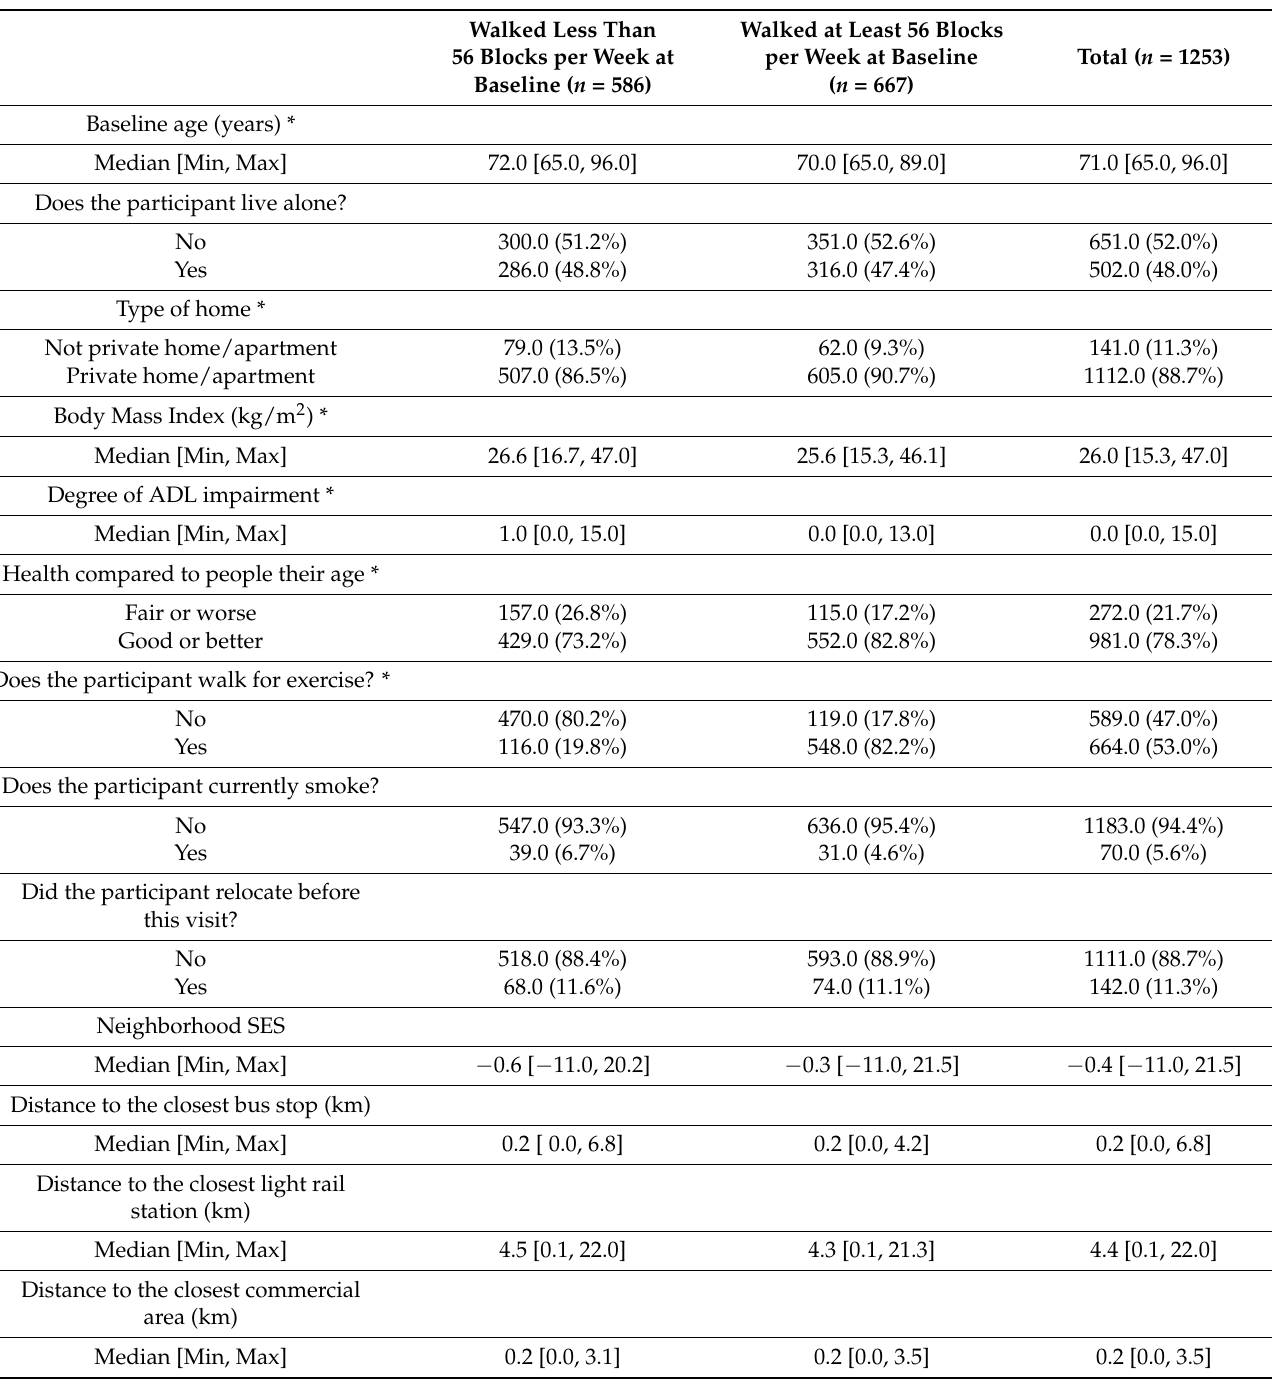
Table 1. Baseline characteristics of the sample stratified by number of blocks walked per week at baseline (median total number of blocks walked per week =